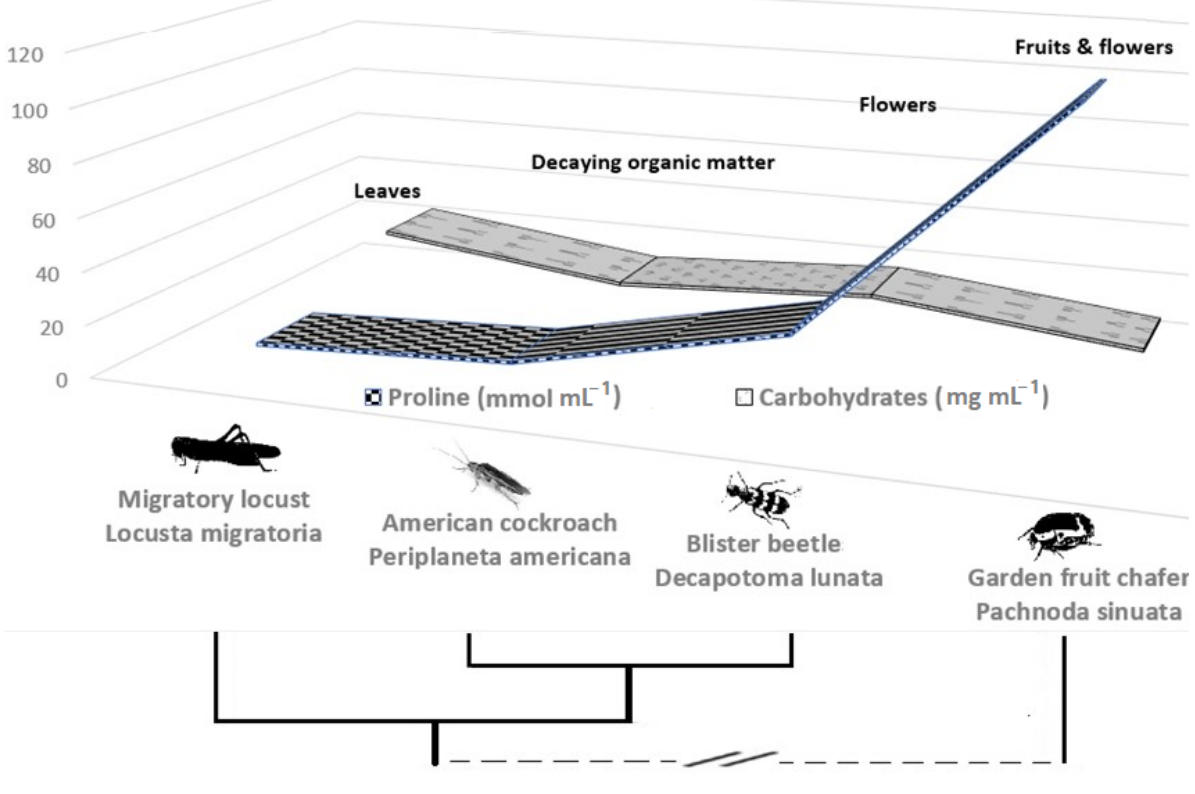
Figure 7. Shifts in concentrations of proline vs. total carbohydrates in the haemolymph of insects—based on insect’s feeding lifestyle and energy substrate (data from Auerswald and Gäde [54]). Together, the findings of Teulier et al. [11] demonstrate that some bee and wasp spe- cies can greatly enhance the oxidation of carbohydrates using proline as fuel for flight. However, there is no evidence suggesting that gut microbiomes [38,58] and symbionts [59] can affect proline biosynthesis in insects—including in the L. migratoria model insect,